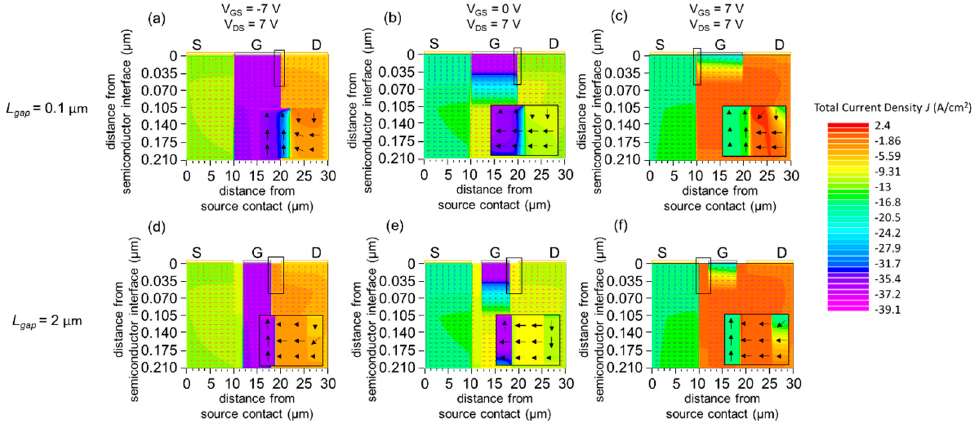
Figure 6. ( a – c ) Simulated total current density J tot (x, y) for L gap = 0.1 µ m ( a ) V GS = − 7 V and V DS = 7 V ( I G -dominant regime), ( b ) V GS = 0 V and V DS = 7 V (off regime), ( c ) V GS = 7 V and V DS = 7 V (normal-operation regime). ( d – f ) Simulated total current density J tot (x, y) for L gap = 2.0 µ m ( d ) V GS = − 7 V and V DS = 7 V ( I G -dominant regime), ( e ) V GS = 0 V and V DS = 7 V (off regime), ( f ) V GS = 7 V and V DS = 7 V (normal-operation regime). The arrows represent the simulated total current density vector. A magnified view of the semiconductor region near the gate electrode (19.8 µm ≤ x ≤ 20.1 µm for ( a , b ), 9.9 µm ≤ x ≤ 10.2 µm for ( c ), 17 µm ≤ x ≤ 21 µm for ( d , e ), 9 µm ≤ x ≤ 13 µm for ( f )) is shown for all panels. The work function of the gate is W G = 5.4 eV. The black boxes indicate the region where the total current density is high.